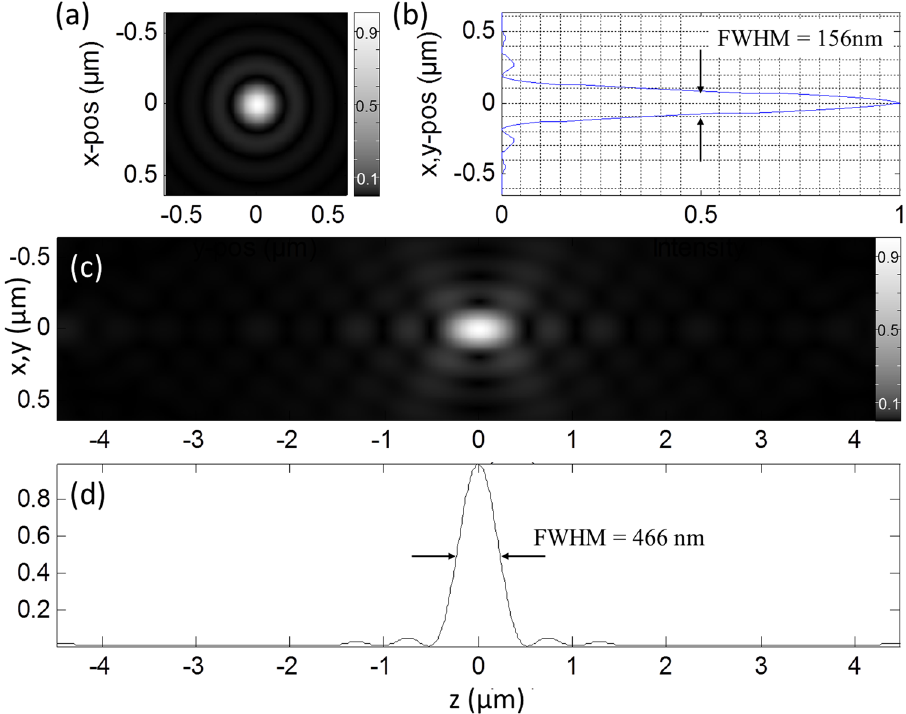
Figure 5. Focal spot for sources covering Ω = 1.25 π . Intensity distribution when imaging with 6,580 sources distributed over π θ π Ω = − . ~ 2 (1 cos ) 1 25 (this corresponds to an objective lens with NA = 1.4). In this calculation, the refractive index at the position of the focus is given by n = 1.518. ( a ) Lateral distribution of the focal intensity F(x,y) ( γ = 0.5). ( b ) Profile across the lateral focus intensity distribution along the y-axis. ( c ) x-z- section through the focus intensity distribution ( γ = 0.5). ( d ) Shows the corresponding axial profile F x = y = 0 (z). In principle, the light source may be positioned at an arbitrary large distance from the focal region (also valid for Figs 3, 4 and 6).